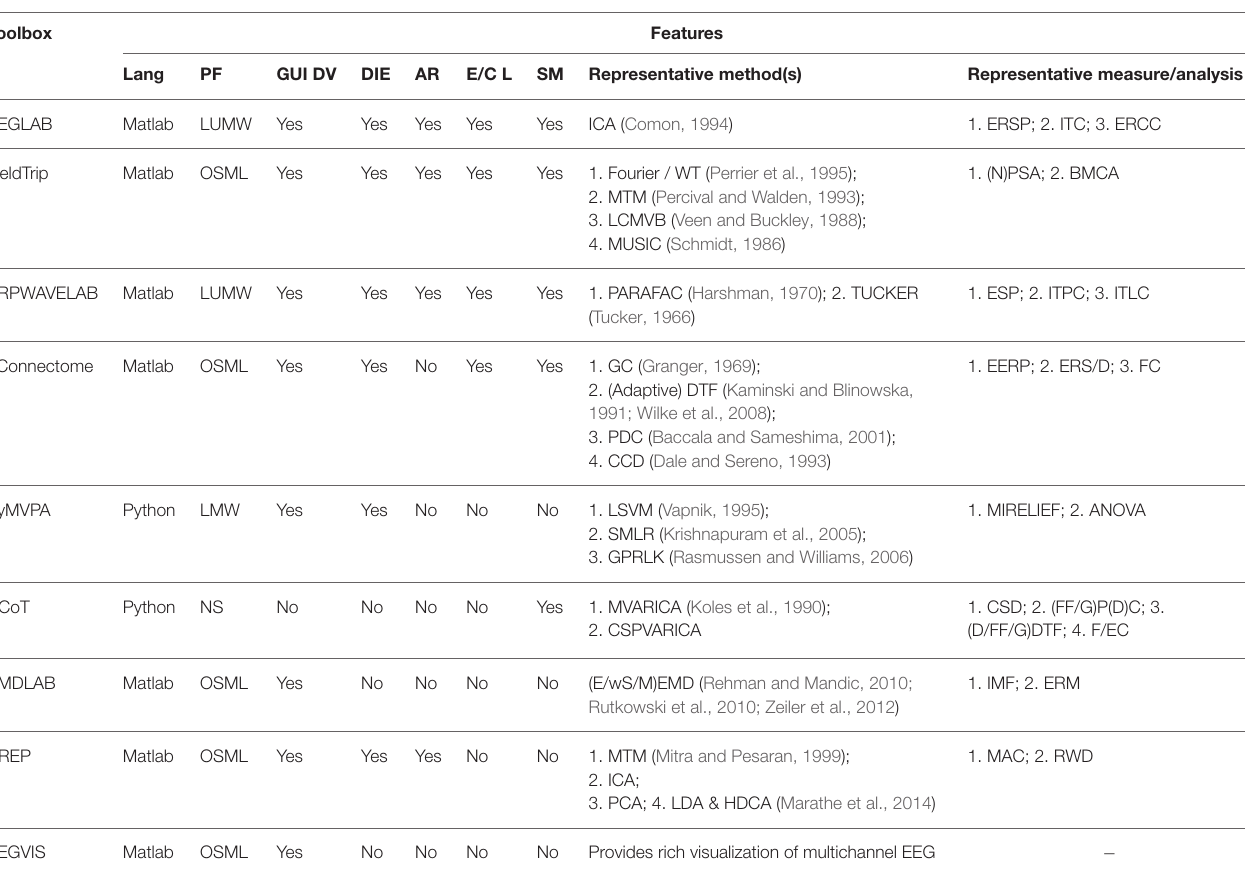
TABLE 1 | Popular EEG processing and analysis toolboxes with their representative features.